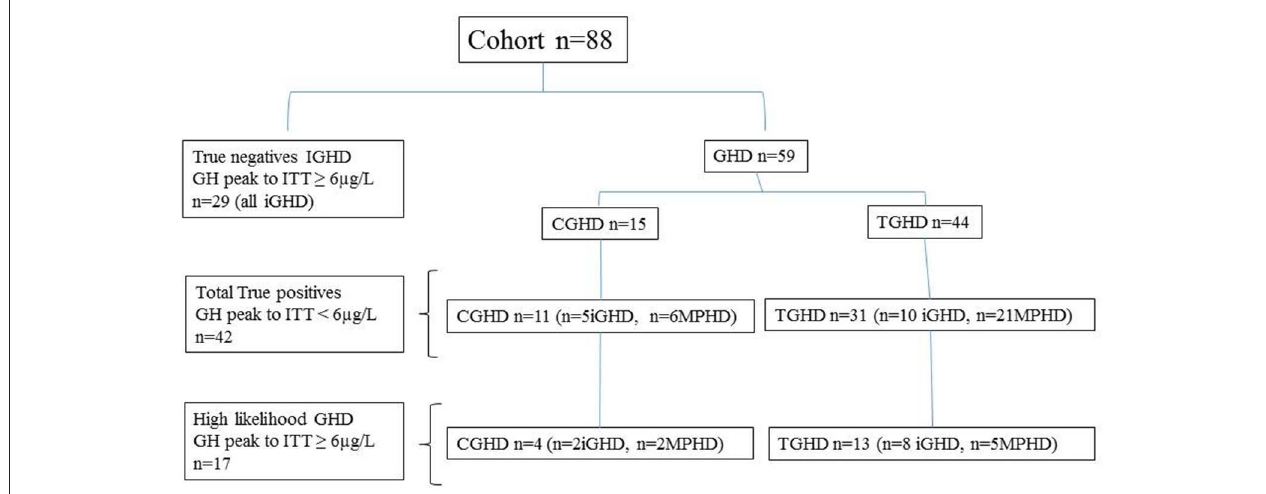
FIGURE 1 | Classification of the patients based on peak GH response to ITT < or ≥ 6 µ g/L, the underlying etiology; idiopathic GHD (IGHD), congenital GHD (CGHD), tumoral GHD (TGHD), and the presence of isolated GHD (iGHD) or multiple pituitary hormone defects (MPHD).